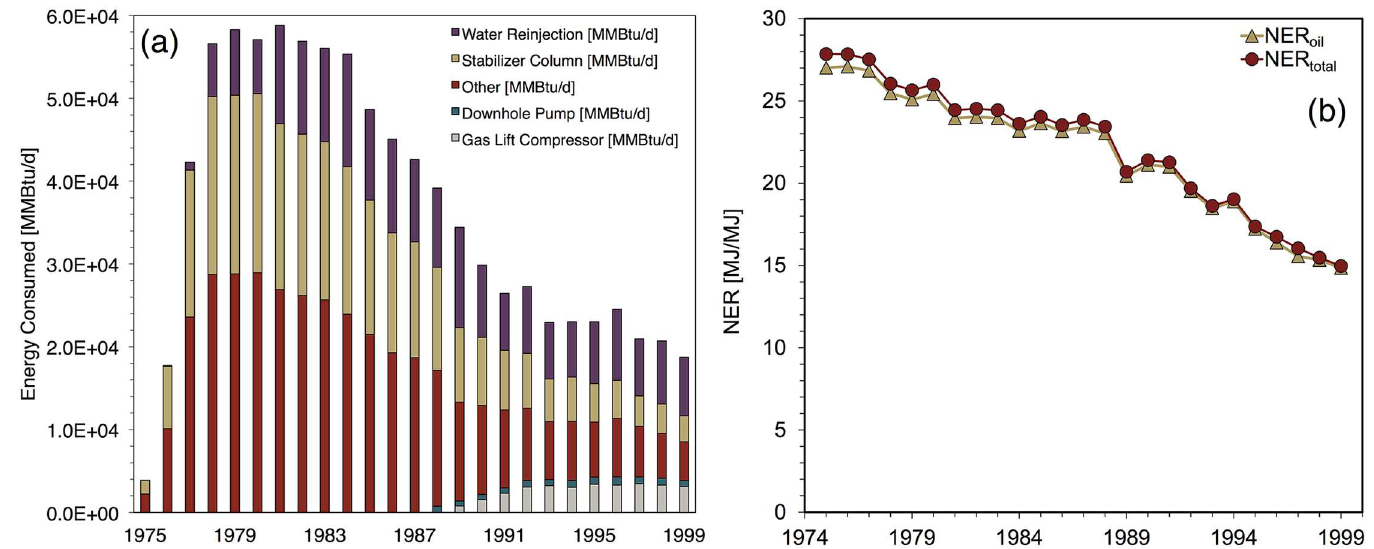
Fig 8. Forties base case results showing (a) total energy inputs for major processes(b) NER